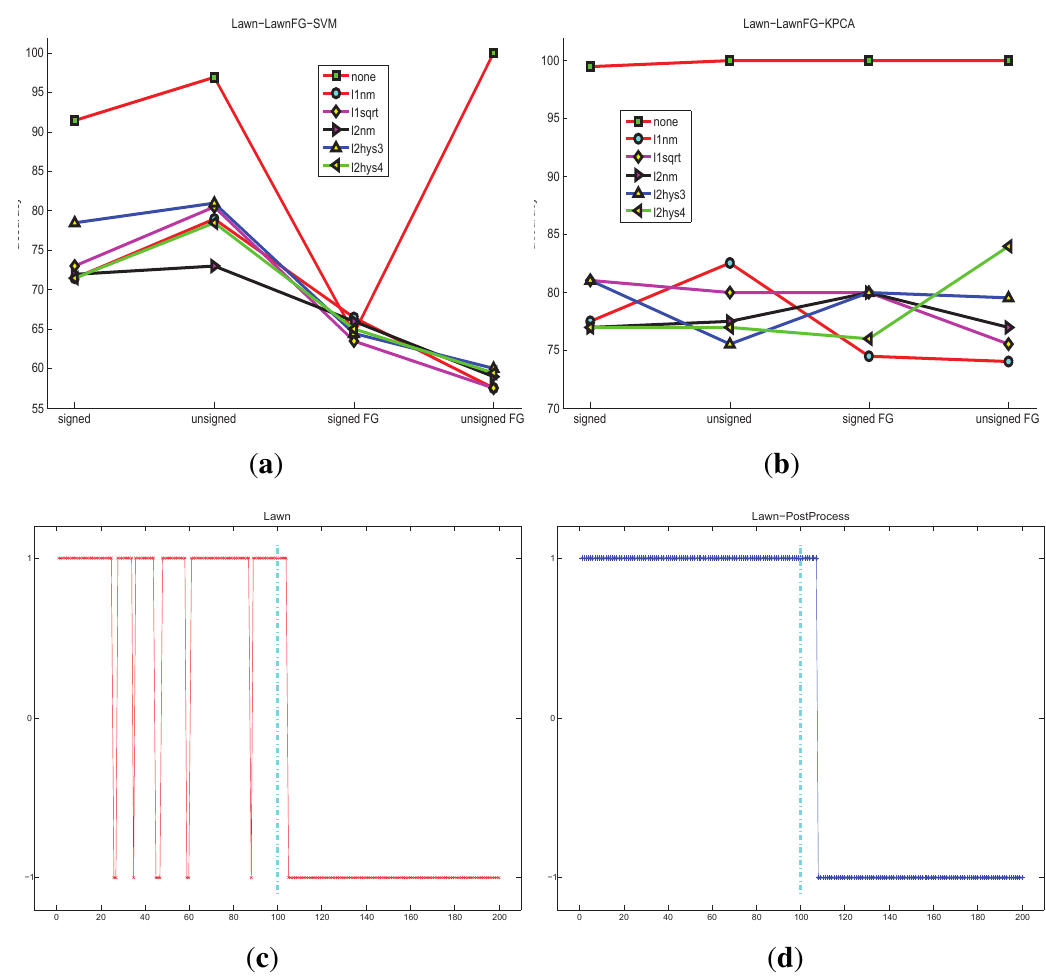
Figure 9. The accuracy of the lawn scene under different classification methods and different features: ( a ) HOFO descriptors are computed on the original image and the foreground image; one-class SVM is taken as the classification method, the maximum accuracy is 100% ; ( b ) HOFO descriptors are computed on the original image and the foreground image; KPCA is taken as the classification method; ( c ) original detection results, the maximum accuracy is 100% ; ( d ) detection results that are post-processed by the state transition restriction strategy; the consecutive frame number threshold is N = 3 . Four hundred and eighty normal frames are used for training; 100 frames are used for normal and abnormal testing,